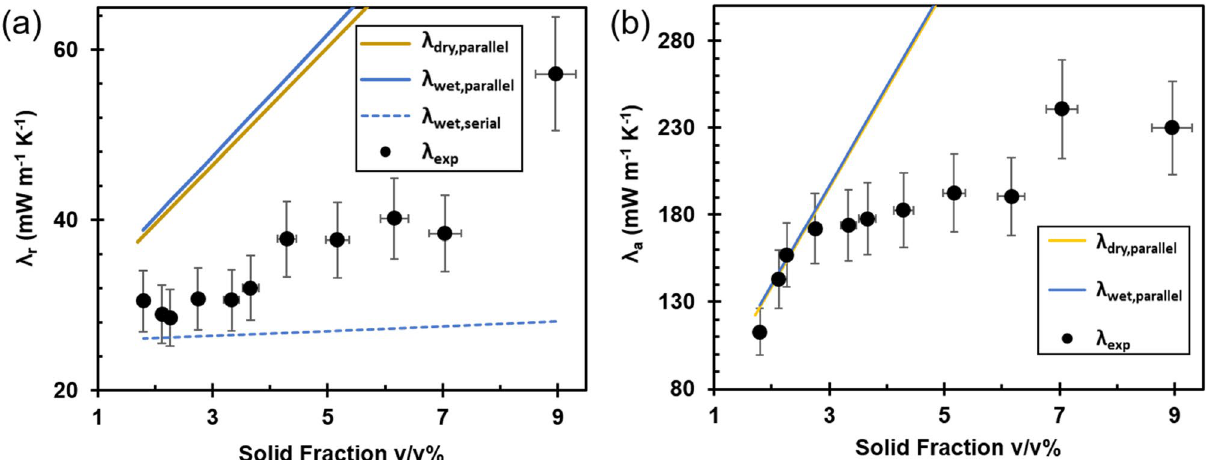
Figure 3. Thermal conductivity of CNC foams as a function of solid fraction (v/v%). ( a ) Radial (λ r ) and; ( b ) axial (λ a ) thermal conductivity of CNC foams as a function of CNC solid fraction (v/v%) at 295 K at 50% RH. The black filled circles correspond to experimental data, while the solid lines correspond to volume-weighted parallel sum-based theoretical estimates of the thermal conductivities, at; (i) dry (λ dry,parallel ) and (ii) 50% RH wet conditions (λ wet,parallel ), and the dotted line corresponds to the serial addition for 50% RH wet conditions (λ wet,serial